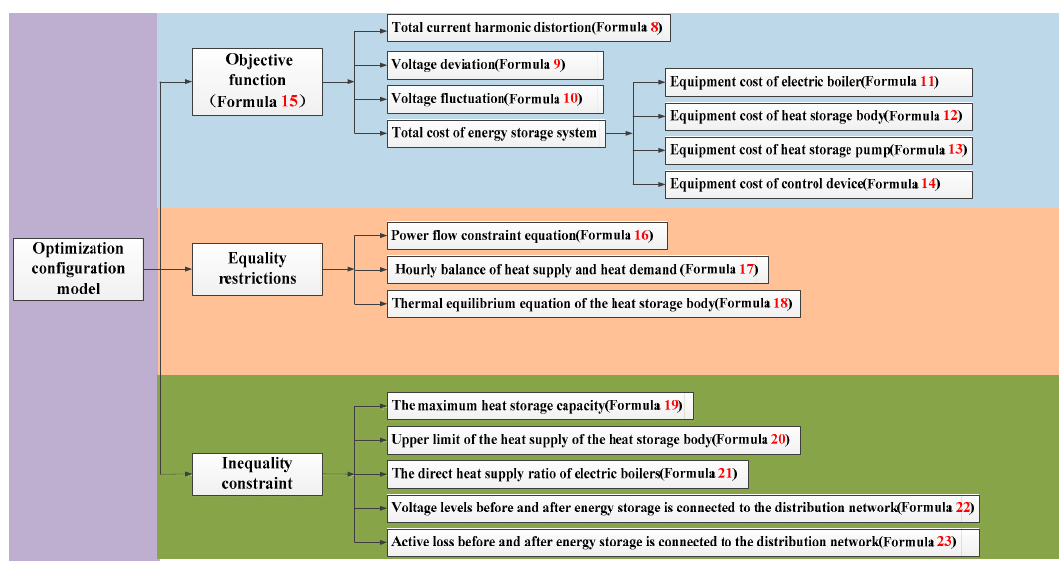
Figure 1. Optimization configuration model. 311